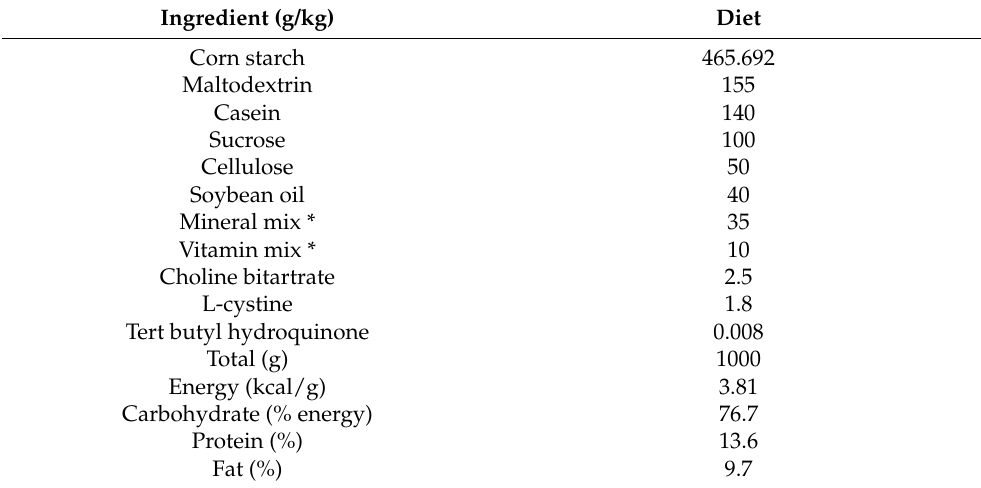
Table 1. Ingredient composition of the experimental